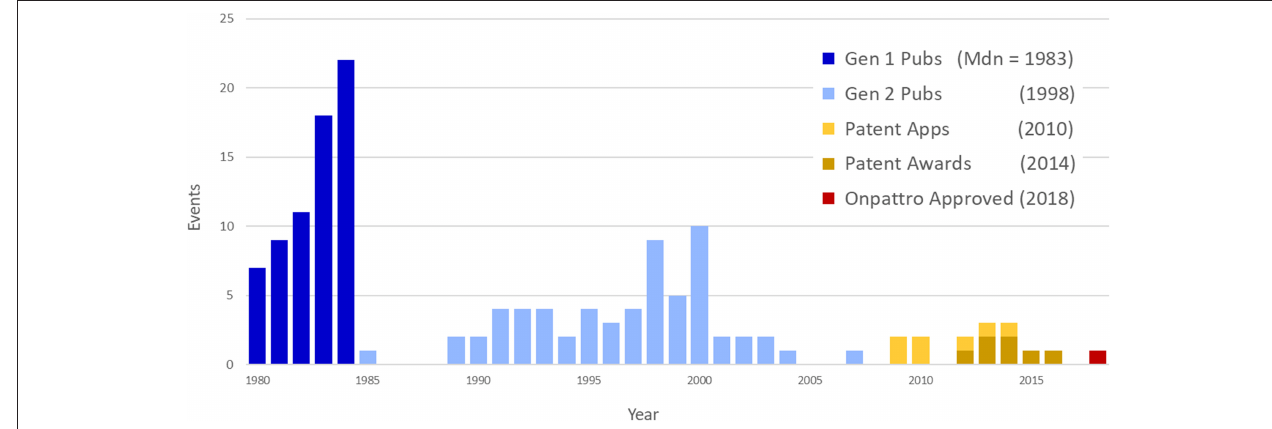
FIGURE 10 | Timeline of events in the Onpattro development network.